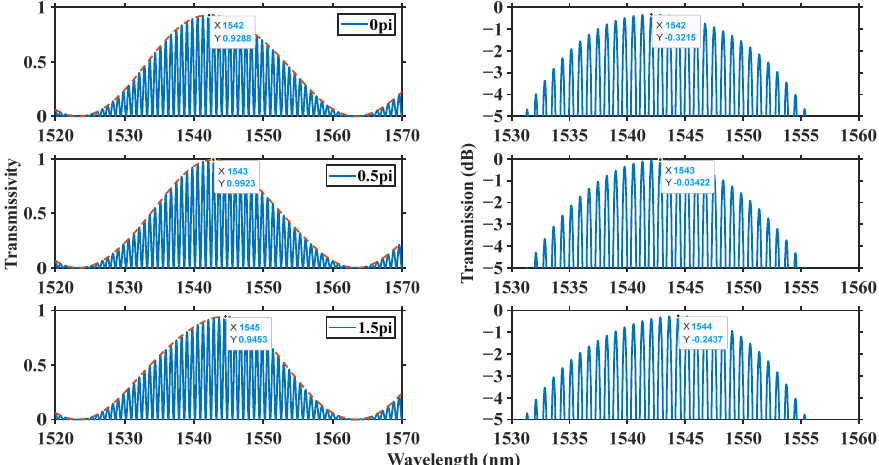
Figure 4. Simulated spectrum of the composite filter with different ∆φ .